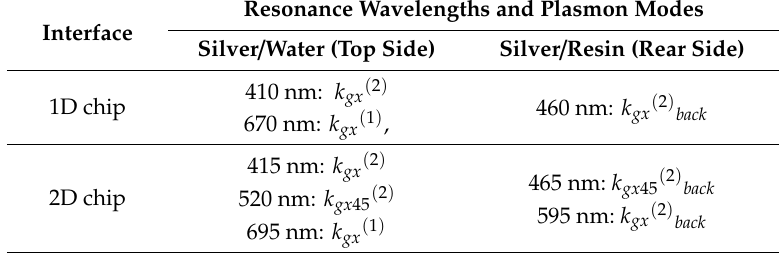
Figure 2. Theoretical dispersion curves of wavenumber vectors k spp for the silver / water (blue solid line) and silver / resin interfaces (gray broken line), and grating vectors k gx ( 1 ) and k gx ( 2 ) for a 480 nm pitch on the 1D chip (red and blue dotted lines (closed circles)), k gx ( 1 ) , k gx ( 2 ) and k gx 45 ( 2 ) for a 500 nm pitch on the 2D chip (red, blue and green dotted line (open circles), respectively). Table 1. The plasmon resonance wavelength of a plasmon mode predicted theoretically at silver / water and silver / resin interfaces on 1D and 2D chips.